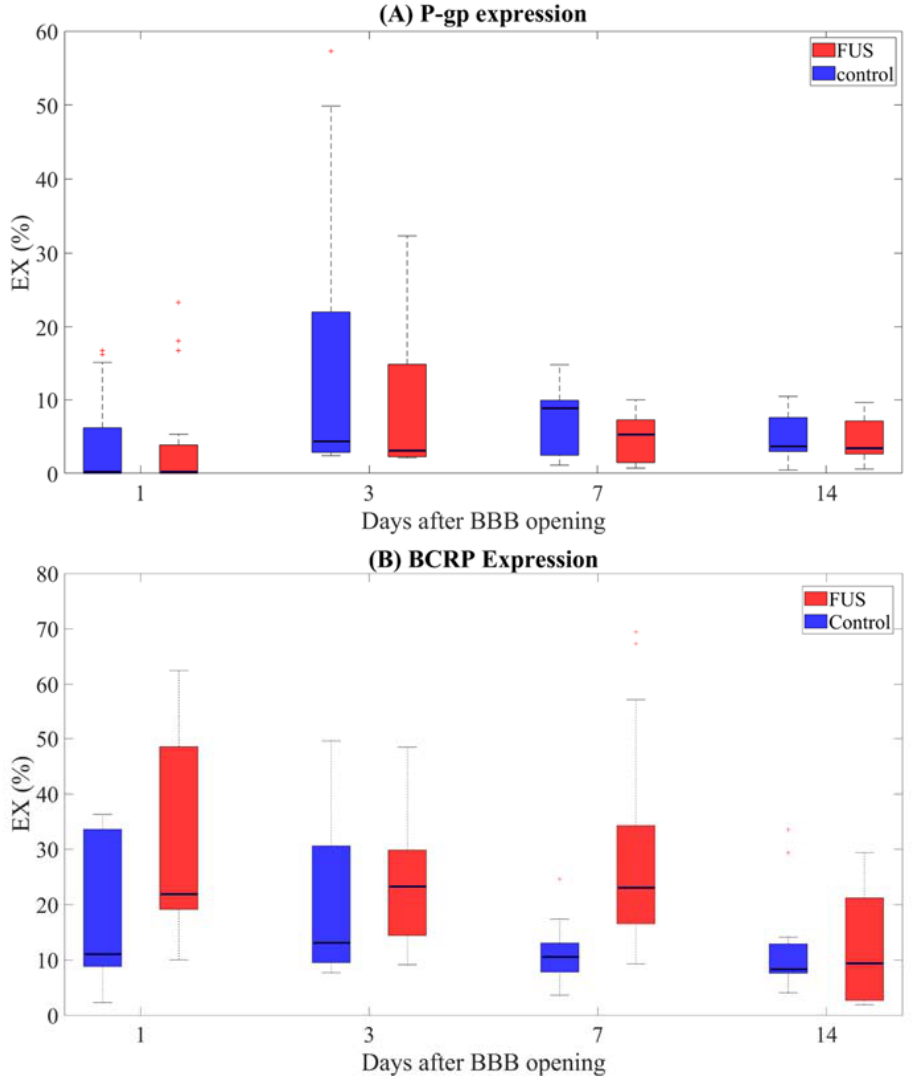
Figure 2. P ‐ gp ( A ) and BCRP expressions ( B ), evaluated over 18 ROIs/time points in both sonicated (in red) and contralateral untreated brain regions (in blue). Table 1. The p ‐ values resulting from the Mann–Whitney tests performed to compare P ‐ gp and BCRP expression between the sonicated and contralateral brain regions at 1, 3, 7, and 14 days after FUS application (18 ROIs per brain hemisphere, at each time point). The p ‐ values were corrected for multiple comparisons (fdr, alpha = 0.05). Corrected p ‐ values less than 0.05 are flagged with one star (*).